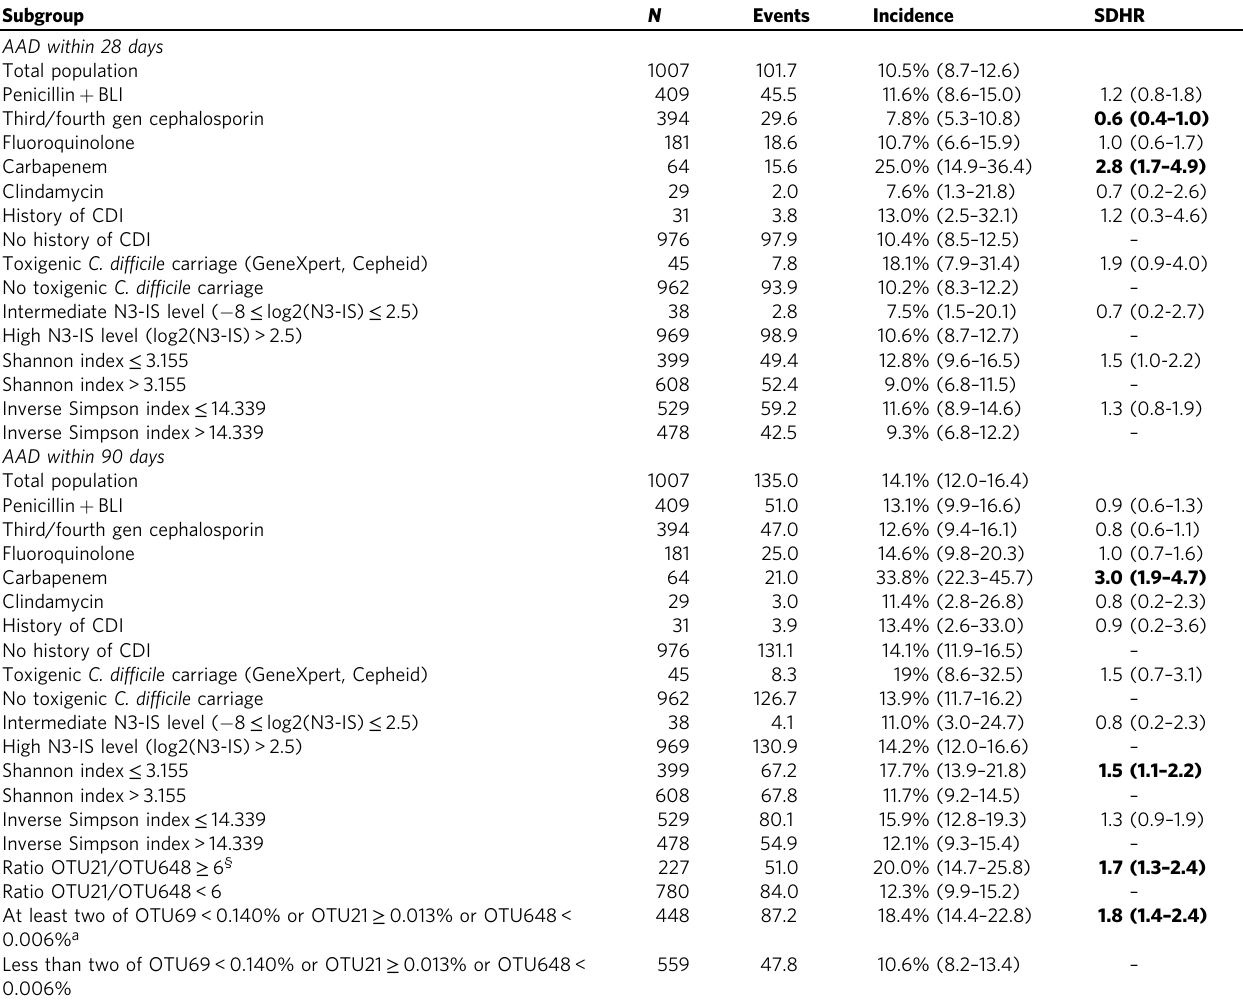
Table 4 Cumulative incidence of AAD within 28 and 90